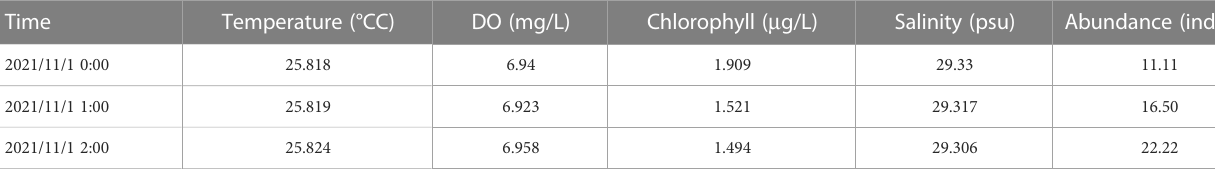
TABLE 1 Partial tip cap snail abundance and environmental